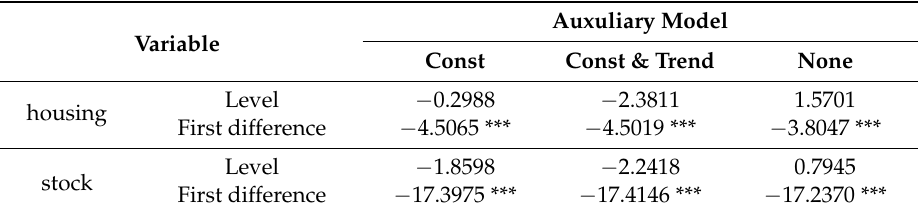
Table 3. Results of an augmented Dickey–Fuller